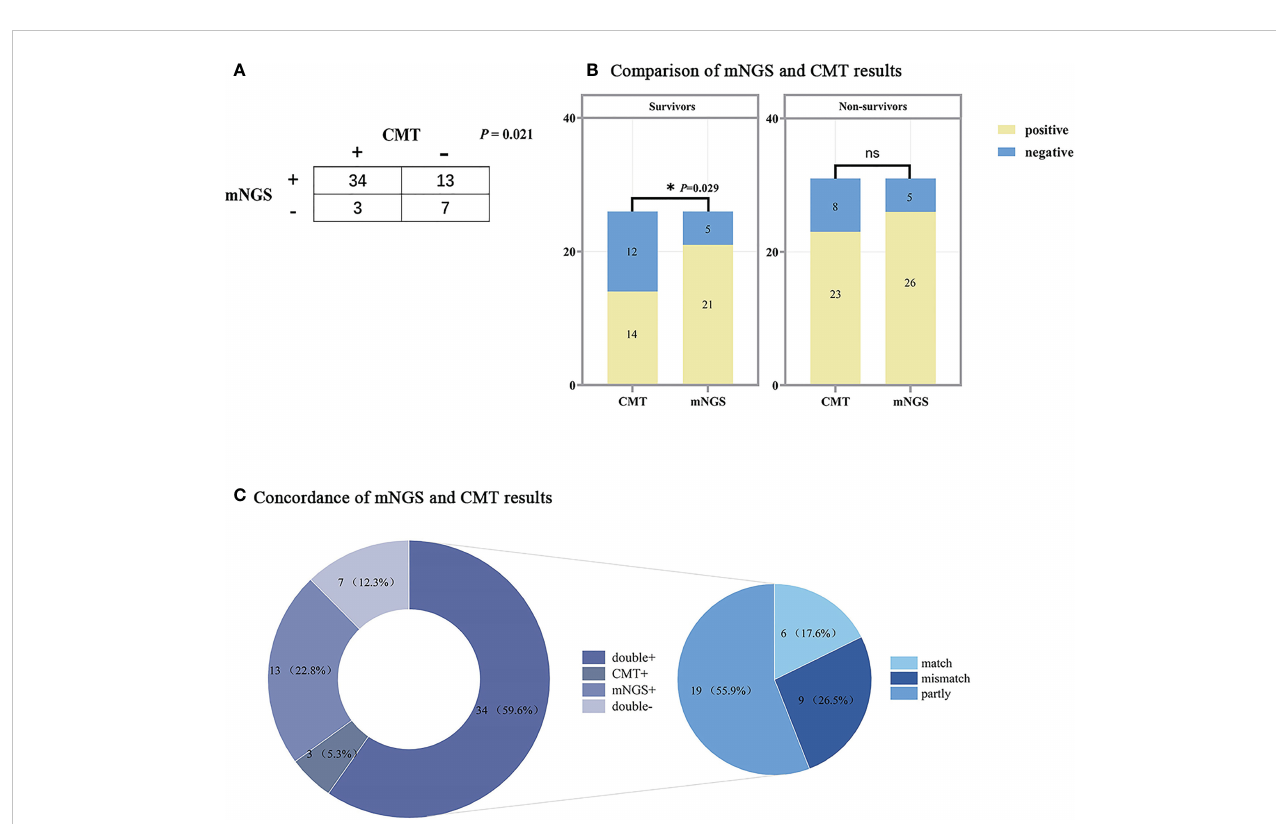
FIGURE 5 Comparison of mNGS and CMT test results. (A) Contingency table of the consistency of mNGS and CMT. (B) Bar chart of mNGS and CMT assay results in the survivors and non-survivors, the results of the two assays were signi fi cantly different in the survivors ( P <0.05). (C) The pie chart shows the distribution of mNGS and CMT results for all patients. The results of the double+ group were further divided into match (6/34), partly match (at least one pathogen con fi rmed by the other in the test) (19/34), and mismatch (9/34). mNGS, metagenomic next-generation sequencing; CMT, conventional microbiological tests. The following are the details of the three ROC curves: SOFA score: Cut-off value=6; AUC=0.956 (95%CI: 0.905-1.000, P<0.001); Sensitivity: 93.6%; Speci fi city: 88.9%. SLEDAI: AUC=0.955 (95%CI: 0.893-1.000, P<0.001); Sensitivity: 96.8%; Speci fi city: 92.6%. APACHE II: Cut-off value=16; AUC=0.930 (95%CI: 0.861-0.998, P<0.001); Sensitivity: 90.3%; Speci fi city: